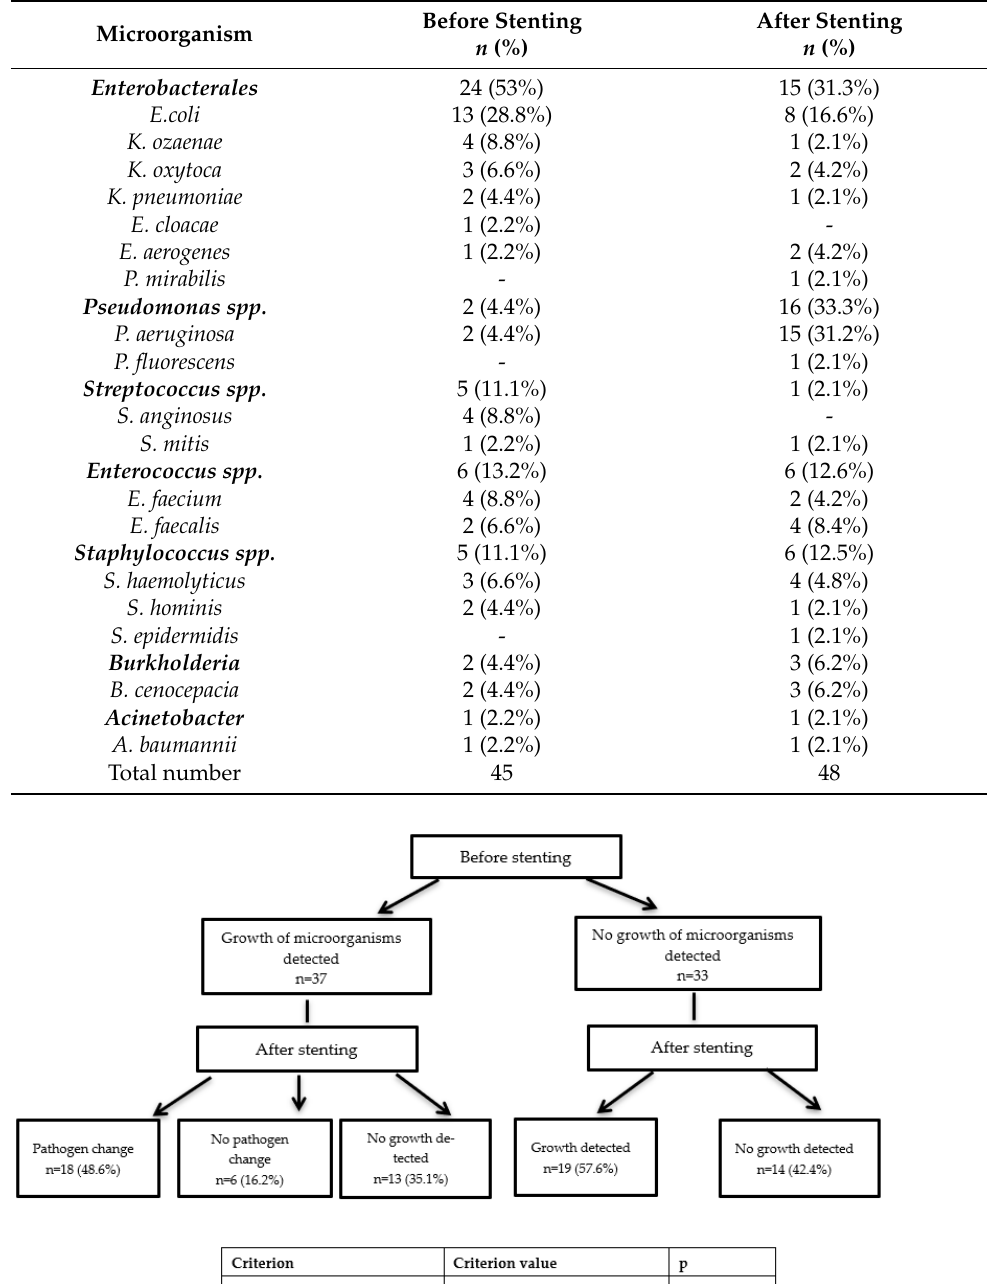
Table 1. Microorganisms detected in urine samples before and after upper urinary tract stenting.